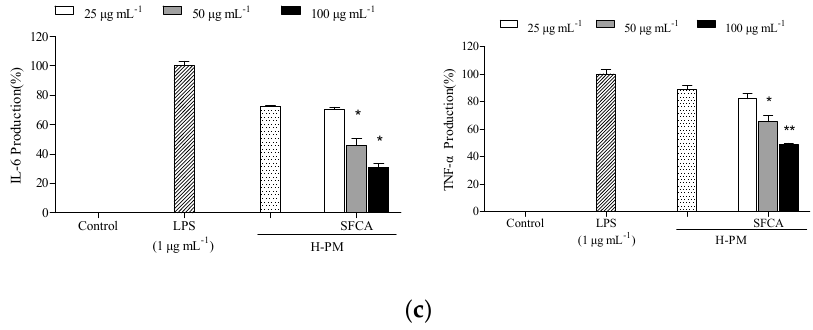
Figure 4. Inflammatory stimulation of the RAW 264.7 macrophages by the culture medium of PM- induced HaCaT cells and the anti-inflammatory effects of SFCA: NO production and cytotoxicity ( a ) and analysis of iNOS and COX-2 levels ( b ) and inflammatory mediators ( c ), including tumor necrosis factor α (TNF- α ), interleukin (IL)-1 β , IL-6, and PGE 2 . HaCaT cells were pre-seeded in culture plates 1 × 10 5 cells mL − 1 ), incubated for 24 h, and treated with or without different concentrations of SFCA. After 1 h, the cells were treated with PM (125 μ g mL − 1 ) and 24 h later, culture media were treated to each pre-seeded RAW 264.7 macrophage culture well plates in real time. The evaluations were conducted after a 24 h. Experiments were carried out in triplicate, and the results are represented as means ± SE. Values are significantly different from the positive control (PM treated group) at * p < 0.05 and ** p < 0.001. H-PM: cultured medium of PM-stimulated in keratinocytes.